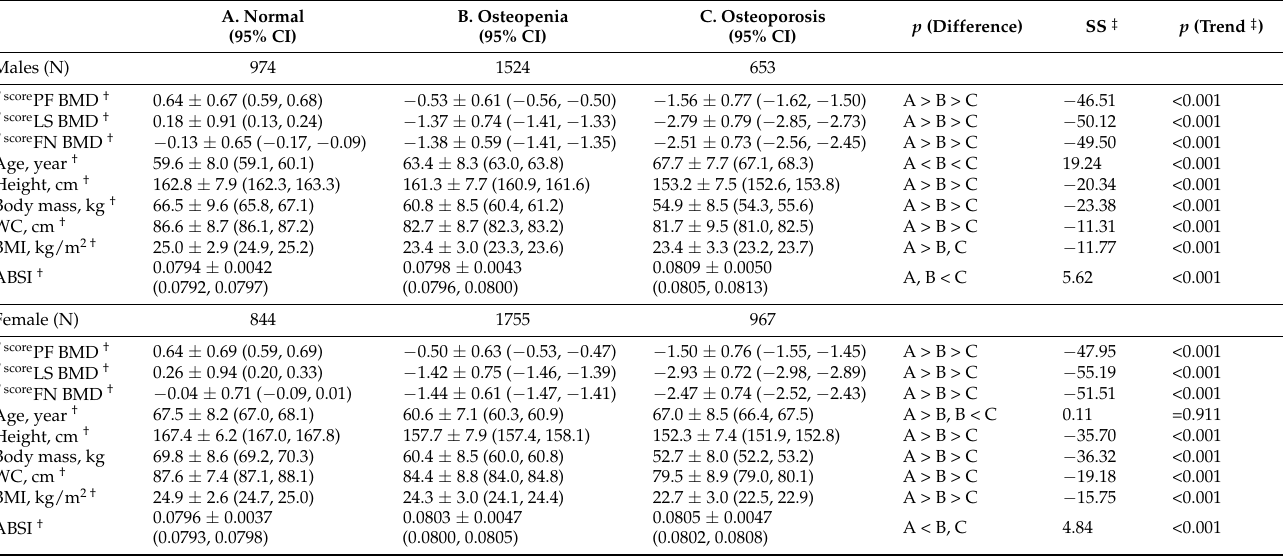
Table 2. Differences between and trends across bone health groups in men and